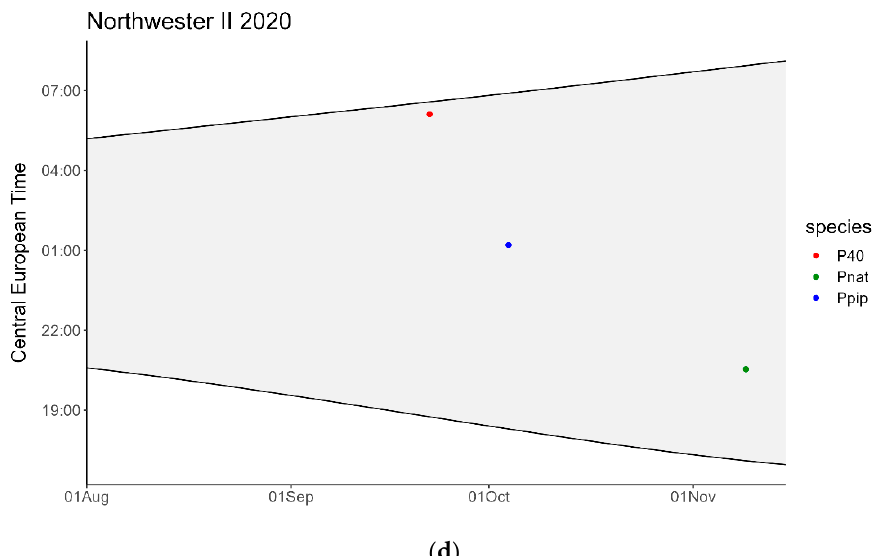
Figure 2. Actograms of all recordings of bat call sequences during the 2017 and 2020 surveys for the different survey locations: ( a ) C-Power; ( b ) Scheur-Wielingen; ( c ) Norther; ( d ) Northwester II. The C-Power graph includes the data for all seven batcorders that were used in that survey. Sunrise and sunset are indicated by the black lines. Pnat: Pipistrellus nathusii ; Ppip: P. pipistrellus ; P40: P. nathusii / P. pipistrellus / P. kuhlii .